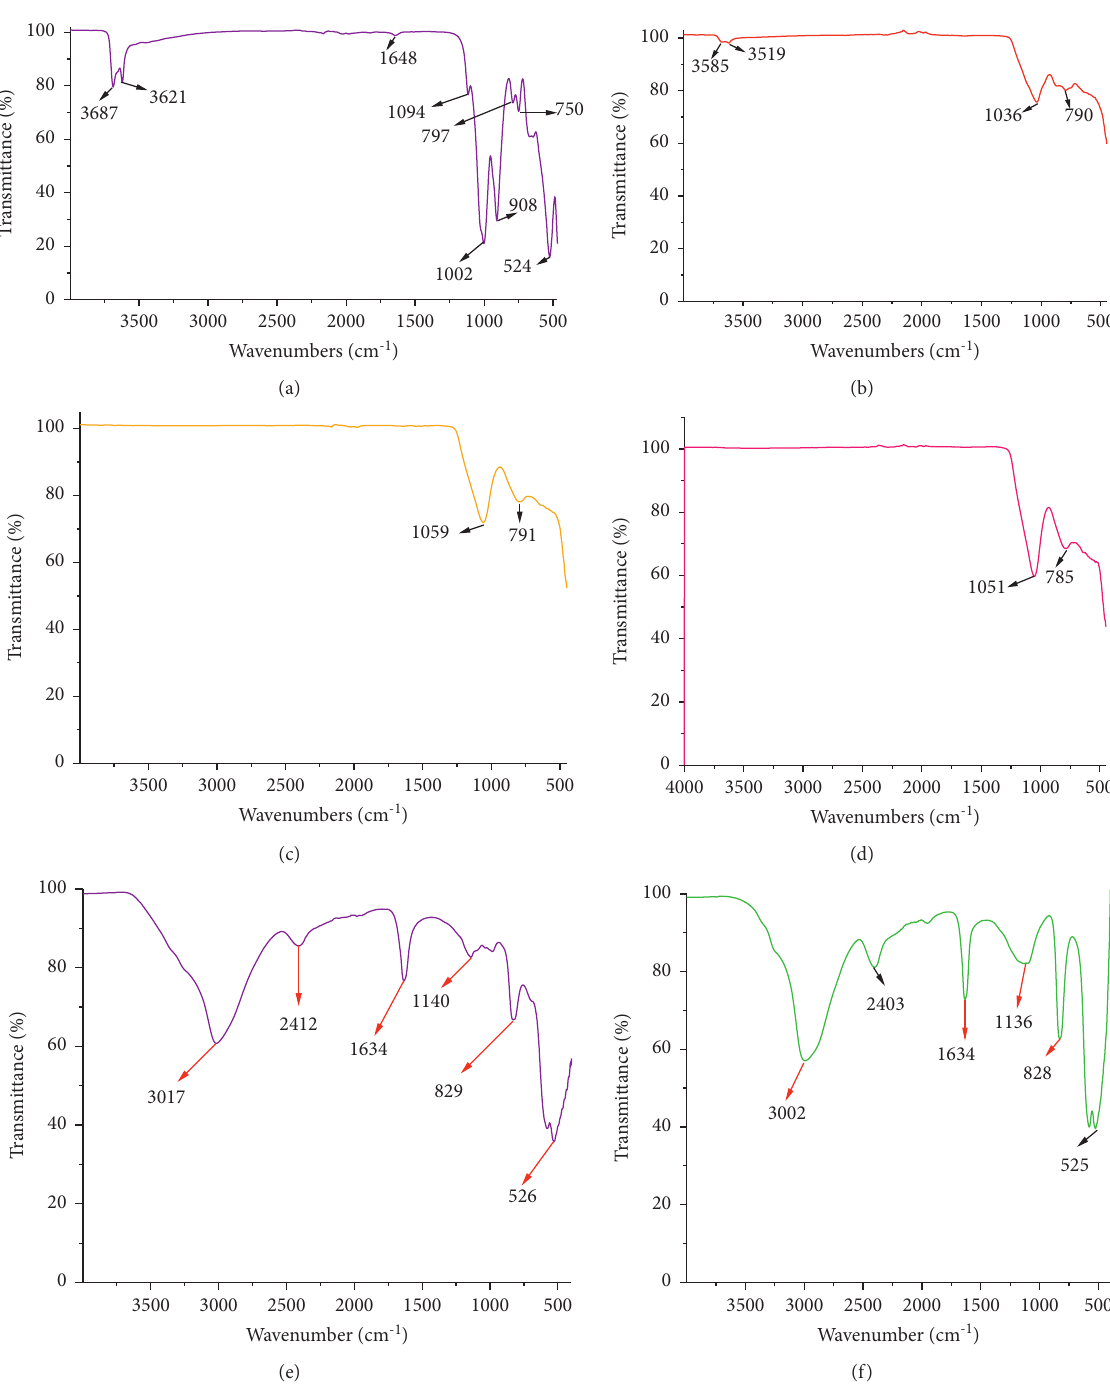
Figure 2: FTIR curves of (a) kaolinite, (b) calcined kaolinite at 600 ° C, (c) calcined kaolinite at 650 ° C, (d) calcined kaolinite at 700 ° C, (e) extracted aluminum at 700 ° C, 180min, and 106 μ m, and (f) standard aluminum chloride